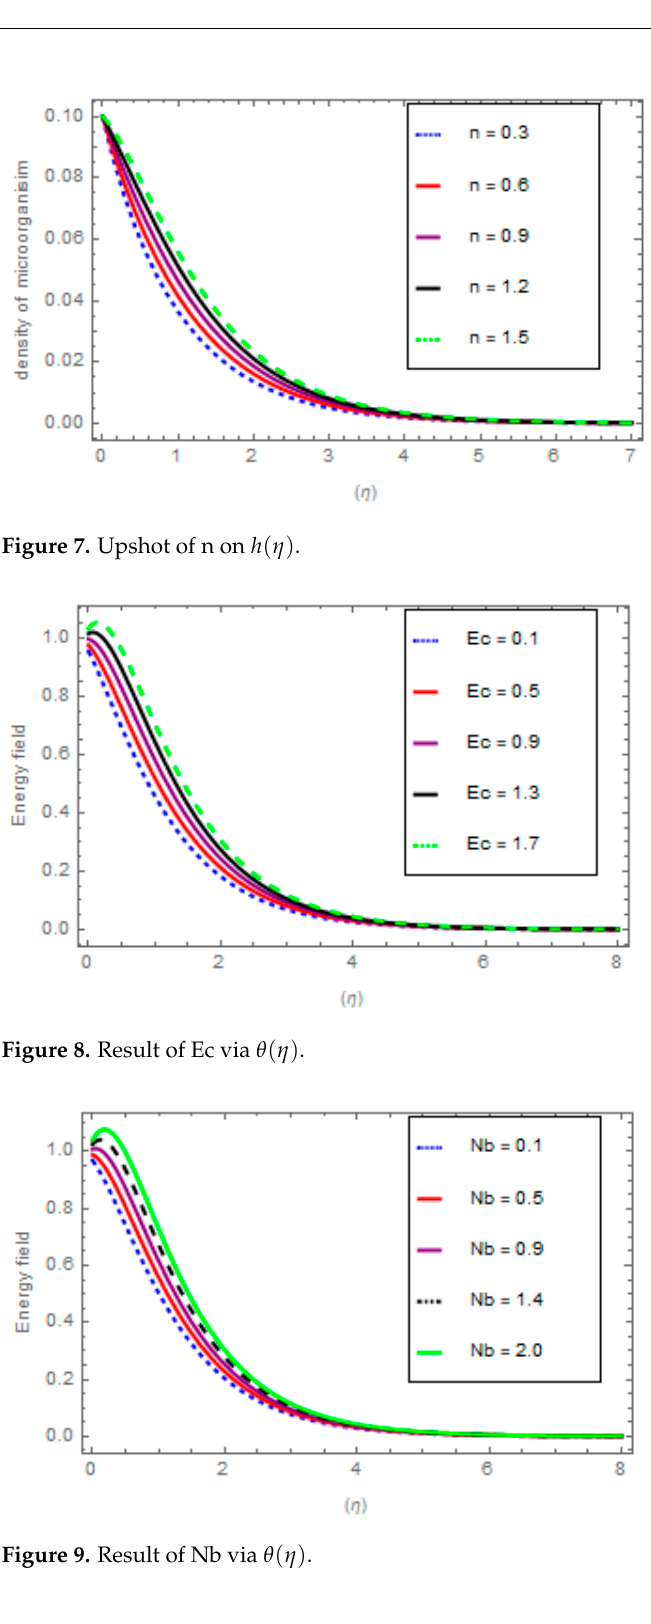
Figure 9. Result of Nb via θ ( η )